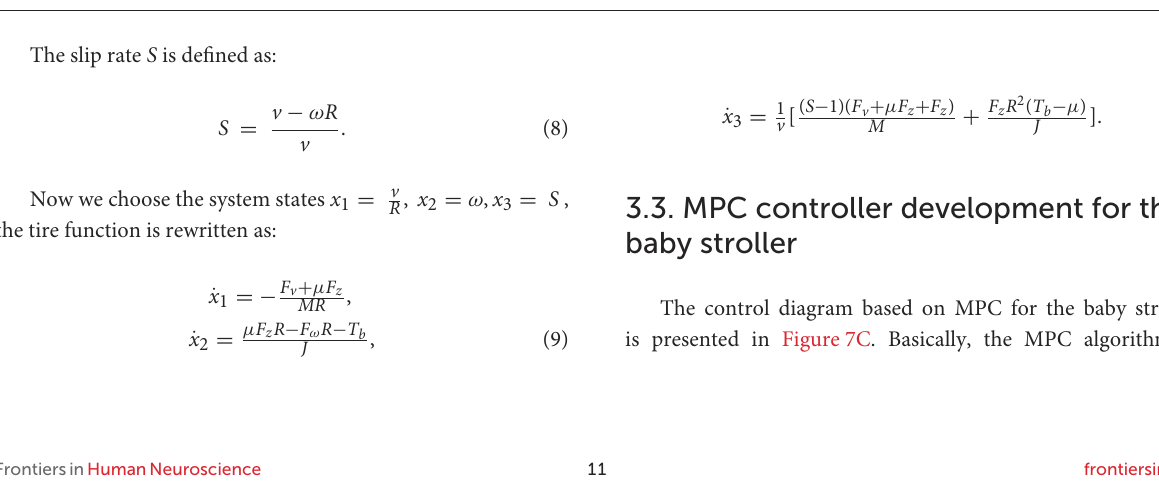
FIGURE7 (A) Kinematic model of the four-wheeled baby stroller. (B) Dynamic model of the four-wheeled baby stroller and the tire model. (C) The MPC control diagram for the baby stroller.